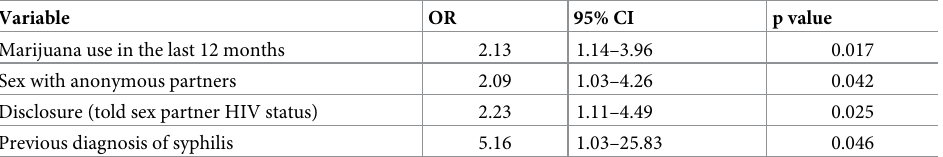
Table 3. Results of multivariable logistic regression of the independent correlates of prevalent syphilis for having a diagnosis of syphilis among MSM living with